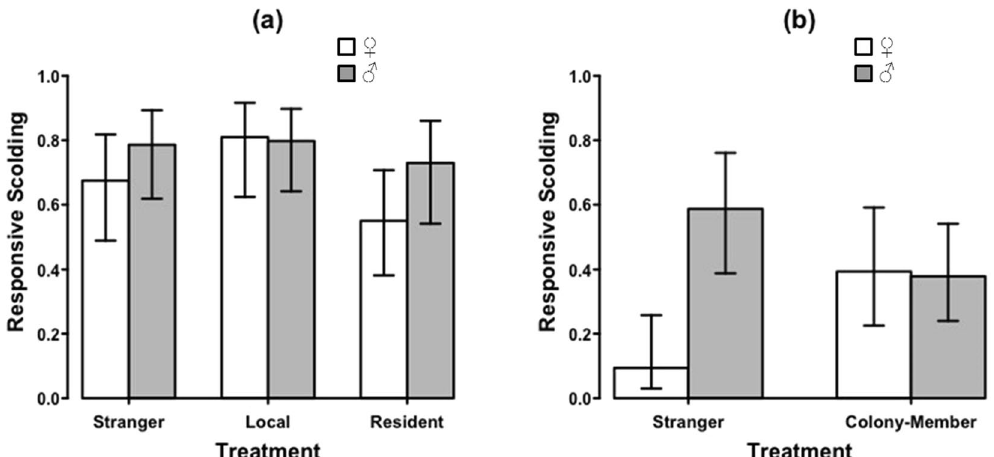
Figure 1. Probability of responsive scolding to jackdaw playbacks ( a ) near to and ( b ) away from nests, depending on caller sex (white = female; grey = male) and experimental treatment. Bars show means ± SE derived from minimal